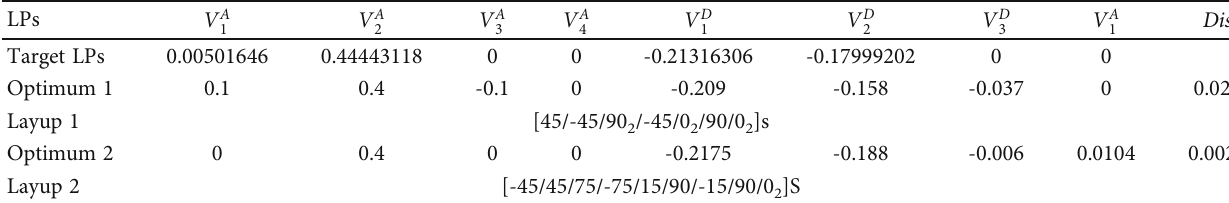
Table 1: Optimal results.